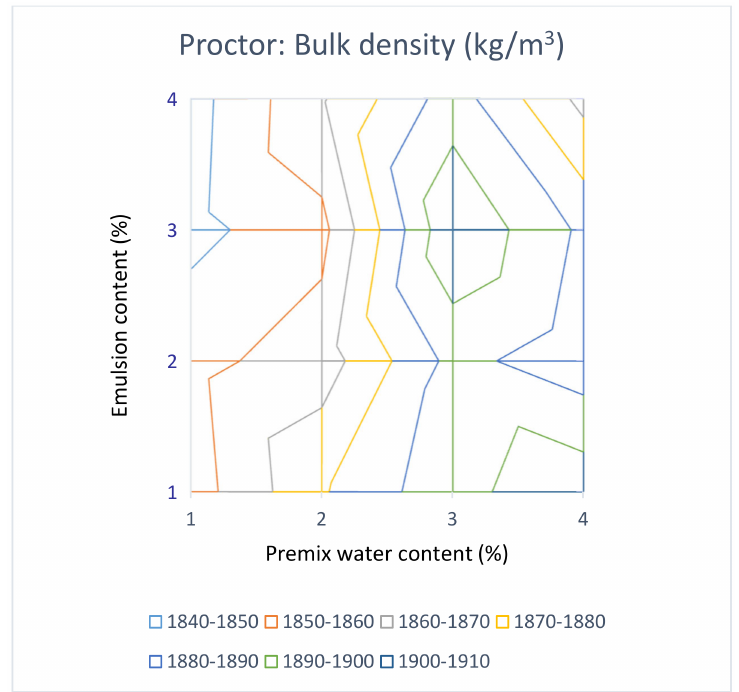
Figure 8. Bulk density for mixtures compacted with the modified Proctor procedure.